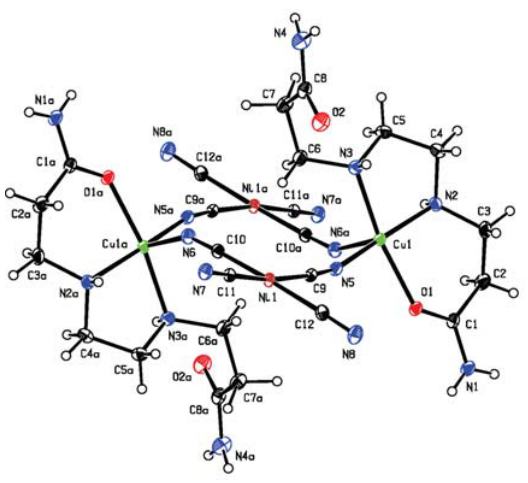
] complex, 1 , with 4 2